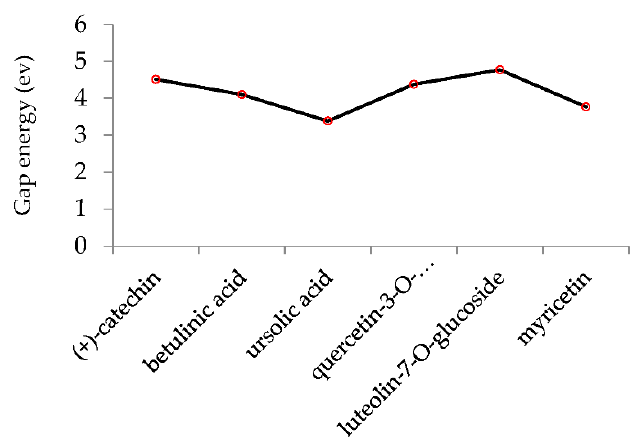
Figure 5. The energy gap (ev) of HOMO–LUMO for (+)-catechin, betulinic acid, ursolic acid, quercetin-3-O-galactoside, luteolin-7-O-glucoside, and myricetin in Sarracenia purpurea drug.